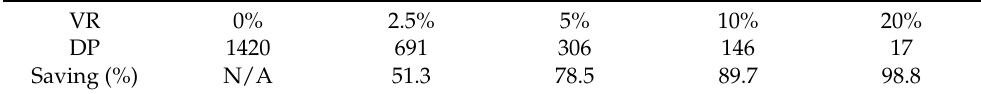
Table 3. Data savings for different values of variance rate (24 h